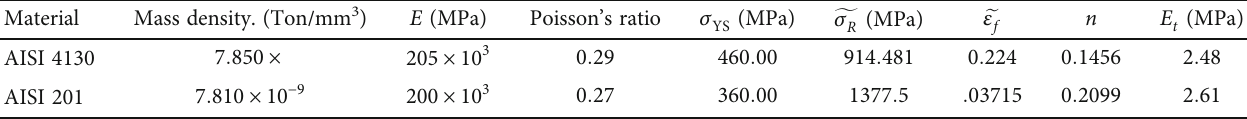
Table 4: Mechanical properties of AISI 4130 and AISI 201 Steel.